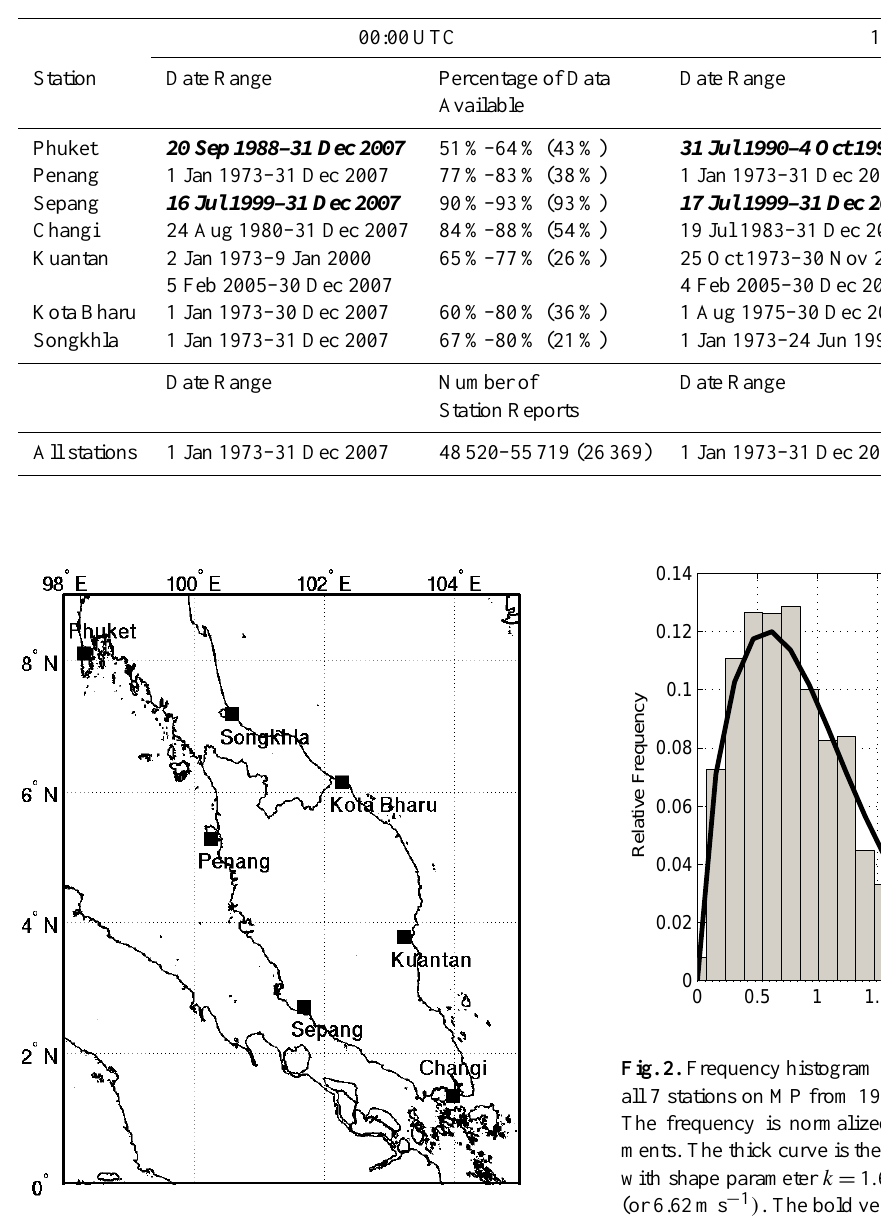
Fig. 1. Location of radiosonde stations on the Malay Peninsula (MP) used in this study.